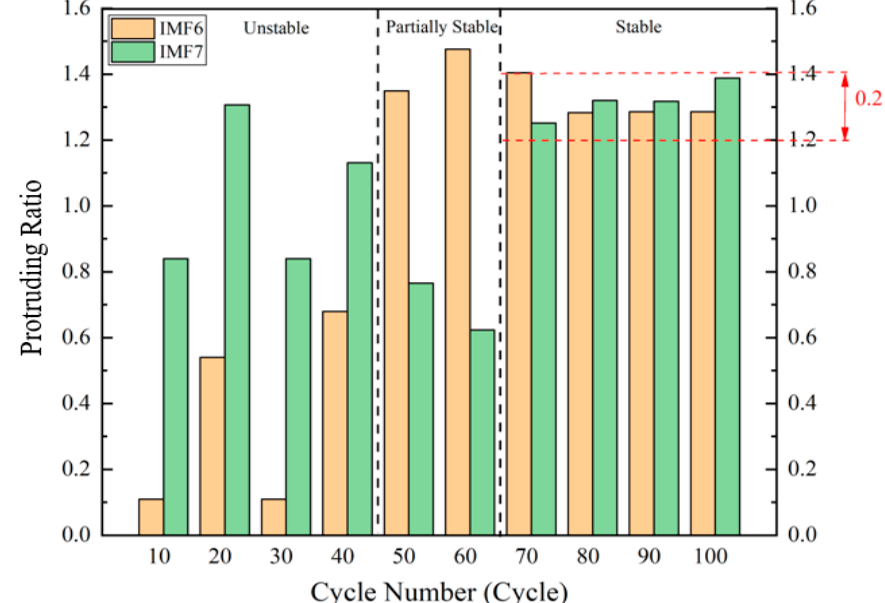
Figure 10. Protruding ratio ( PR ) of adaptive cyclic average TVF-EMD with different ensemble averaging time: 10 cycles to 100 cycles.